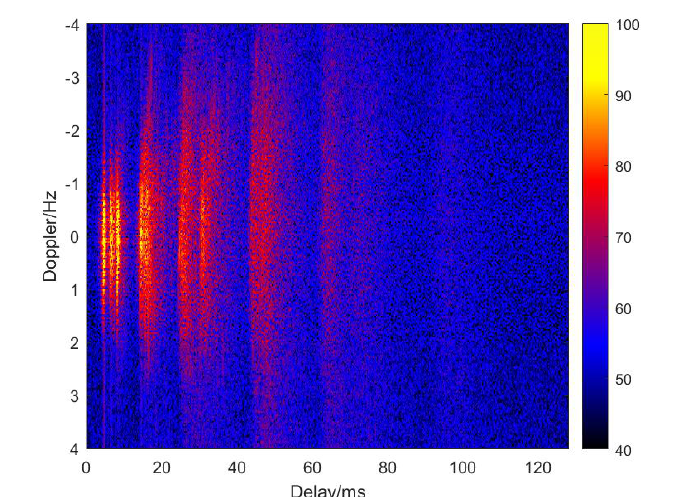
Figure 10. CIR in time domain under KAU1 experiment.